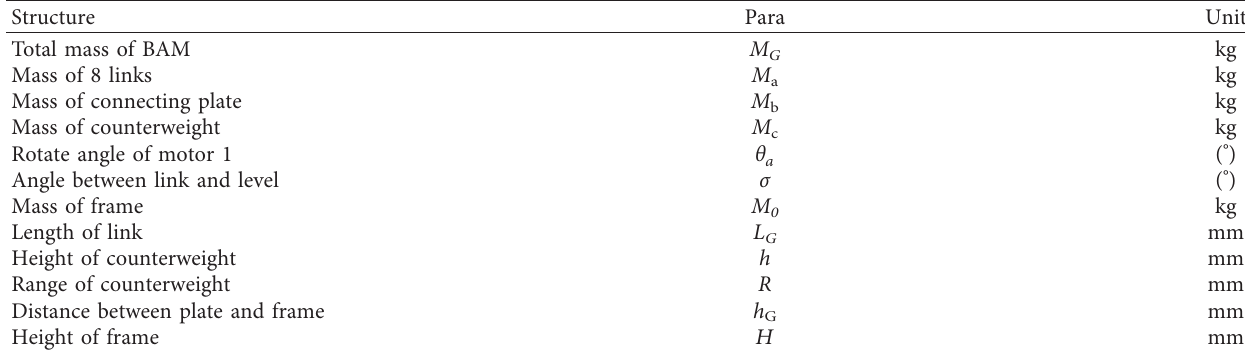
Table 1: Parameter of the barycenter balance